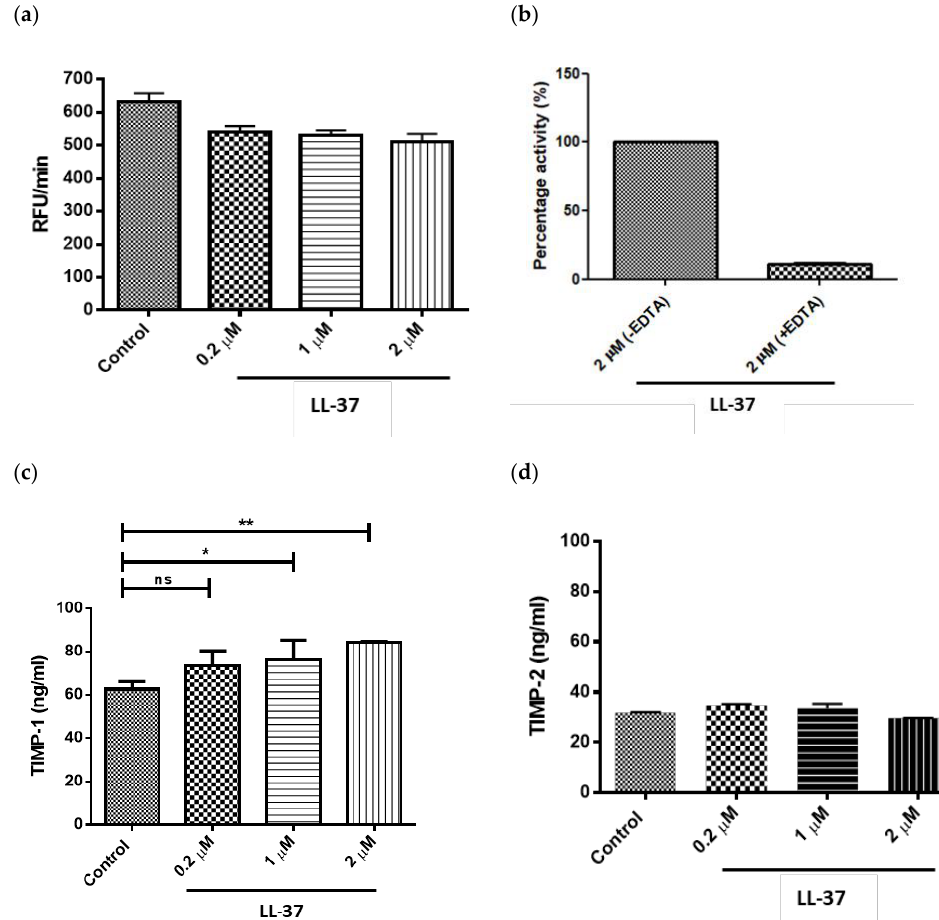
Figure 2. Direct effects of LL-37 on matrix metalloproteinase (MMP) activity and tissue inhibitor of metalloproteinase (TIMP) production. Effects of LL-37 on ( a ) secreted MMP activities and ( b ) inhibition of MMP activities in the presence of EDTA in LL-37-treated gingival fibroblasts. Effects of LL-37 on ( c ) TIMP-1 and ( d ) TIMP-2 secretion by gingival fibroblasts. Cells were incubated in medium